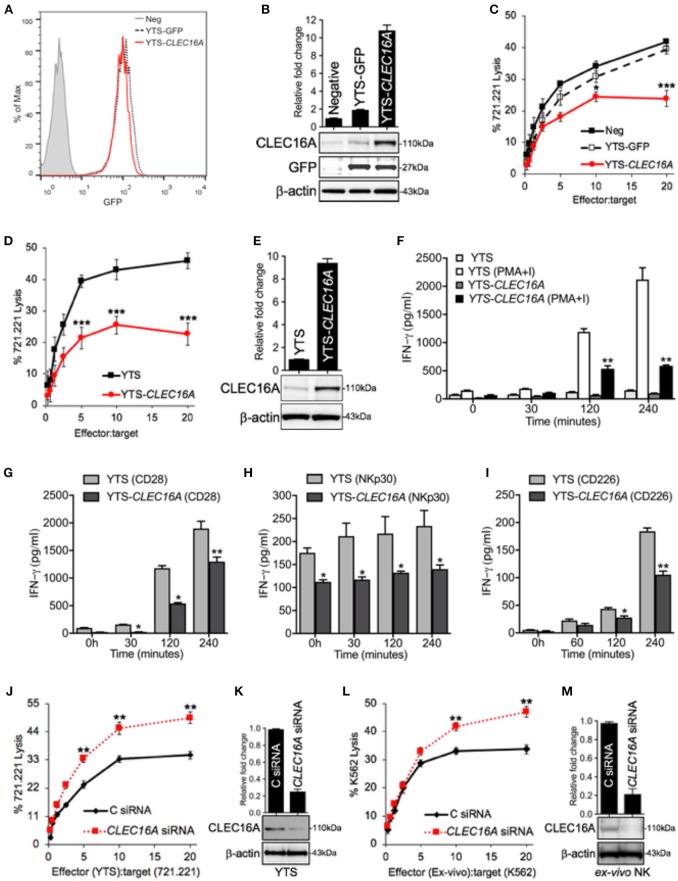
CLEC16A overexpression impairs cytotoxicity, IFN-γ production and DC maturation, whereas siRNA mediated knockdown enhances the cytotoxicity in NK cells. (A) Transduced YTSeco cells were sorted via FACS into population with comparable GFP expression and cultures had consistent GFP expression over time. (B) Negative, YTS-GFP, and YTS-CLEC16A cells analyzed for CLEC16A and GFP expression in an immunoblot analysis. Membranes were stripped and re-probed for β-actin as a loading control (bottom panel). Quantitation graph depicting CLEC16A expression (top panel; n = 3 repeats). (C) Cytotoxicity of negative control (mock transduced YTS cells), YTS-GFP and YTS-CLEC16A NK cell lines against 51Cr-labeled 721.221 targets. Data represents means ± SE of five independent experiments. (D) Cytotoxicity of parental YTS and YTS-CLEC16A NK cells against 51Cr-labeled 721.221 target. Data represents means±SE of three independent experiments (E) Representative Western blot of YTS and YTS-CLEC16A cells for CLEC16A expression and β-actin (bottom panel). Quantitation graph depicting CLEC16A expression (top panel; n = 3 repeats). (F,I) CLEC16A overexpression limits IFN-γ production in YTS-CLEC16A. IFN-γ release measured by ELISA in YTS and YTS-CLEC16A NK cell lines at the indicated time points. Data represents means ± SE of three independent experiments. (F) Cell lines were cultured alone or with PMA and ionomycin (PMA+I). (G) YTS and YTS-CLEC16A cells were activated with plate bound anti-CD28 for the indicated time points shown. (H) YTS and YTS-CLEC16A cells activated with plate bound anti-NKp30 for the indicated time points shown. (I) YTS and YTS-CLEC16A cells activated with plate bound anti-CD226 for the indicated time points and IFN-γ release shown. (J) siRNA knockdown of CLEC16A in parental YTS cells. 721.221 target cell killing by YTS cells, 24 h post nucleofection of the YTS cells with either CLEC16A or Control siRNAs. Data represents means ± SE of three independent experiments. (K) Representative Western blot depicting CLEC16A expression after siRNA mediated knockdown in YTS cells. Quantitation graph depicting CLEC16A expression (top panel; n = 3 repeats). (l) siRNA mediated knockdown of CLEC16A in ex vivo NK cells and cytotoxicity. K562 target cell killing by ex vivo NK cells, 24 h after nucleofection of the ex vivo NK cells with either CLEC16A or Control siRNAs. Data represents means ± SE of three independent experiments. (M) Representative Western blot depicting CLEC16A protein expression after knockdown in ex vivo NK cells. Quantitation graphdepicting CLEC16A expression (top panel; n = 3 repeats). *P < 0.05, **P < 0.01, ***P < 0.001 (unpaired two-tailed Student's t-test).